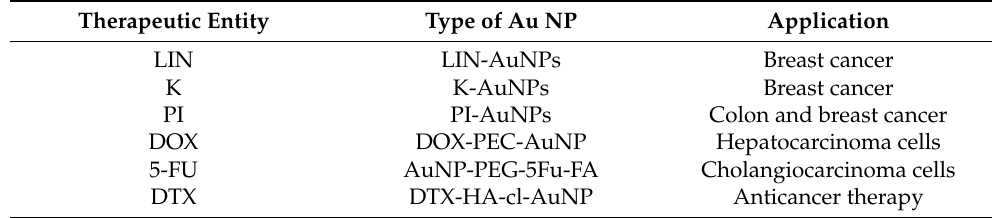
Table 2. Different types of Au-NPs used in cancer therapy.